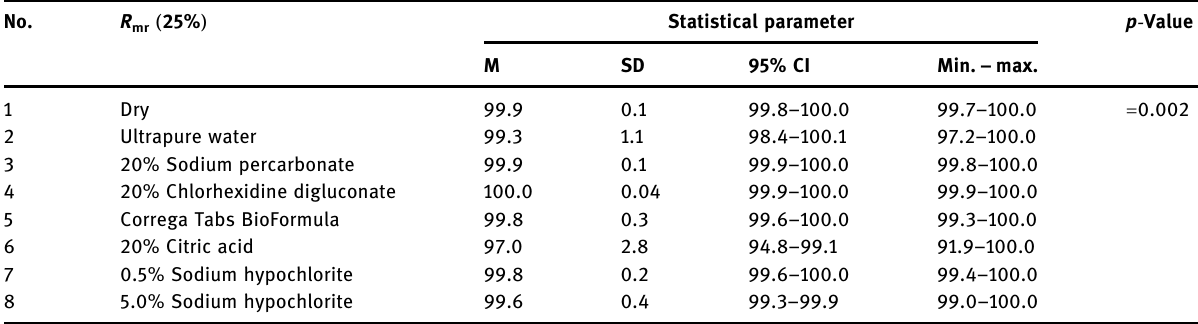
Post - hoc multiple comparisons: ( 6 ) versus all the remaining compounds at p < 0.001.